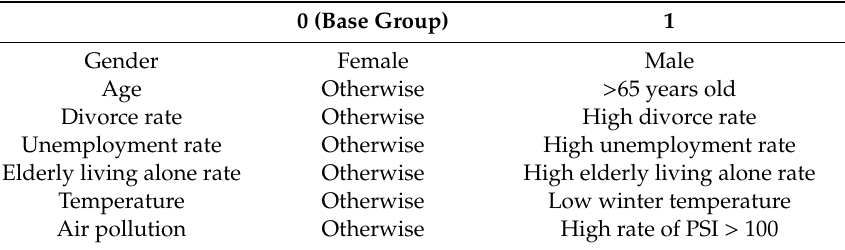
Table 2. The covariate in the proposed SMP model.